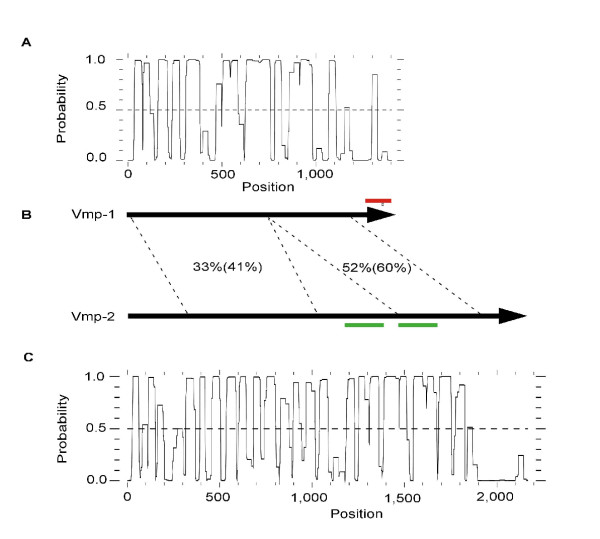
Comparison of Vmp-1 and Vmp-2. A and C: the predicted coiled-coil regions of Vmp-1 and Vmp-2, respectively. A threshold value of 0.5 is shown as a vertical dashed line. B: The identity (similarity) displayed by regions of the Vmp proteins. The C-terminal regions of the protein showed high mutual similarity. Green bars are shown below the repeated sequence of Vmp-2. A red bar indicates the fragment specific for Vmp-1 used for generation of a polyclonal antibody.